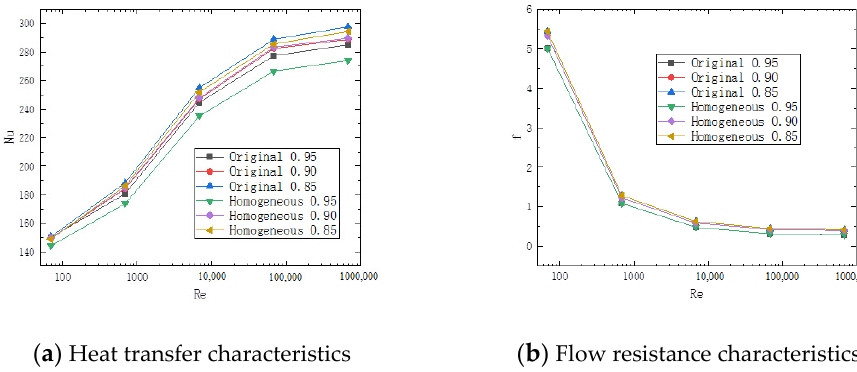
Figure 8. Comparison between the original structure and the homogenized model.